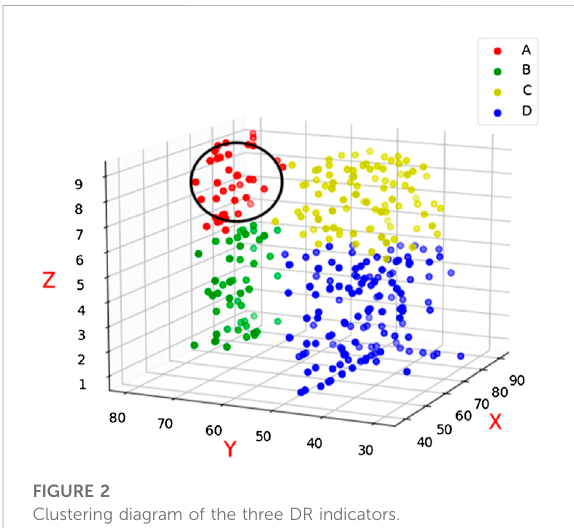
FIGURE 2 Clustering diagram of the three DR